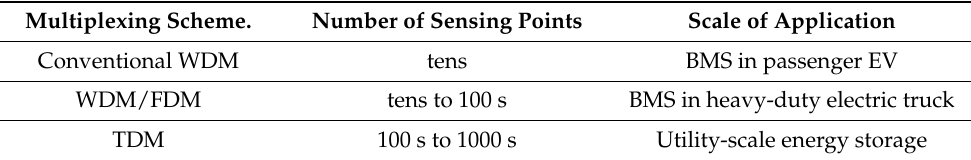
Table 3. Proposed applications for different multiplexing schemes of fiber optic (FO) quasi- distributed